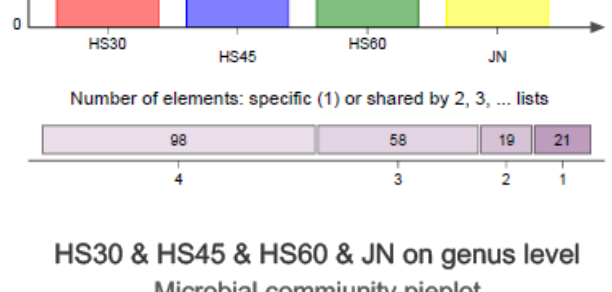
Figure 2 . Common microbes between yellow water and pit mud. A : Venn diagram of yellow water and pit mud, B : Percentage of common microbes between yellow water and pit mud (at the genus level).